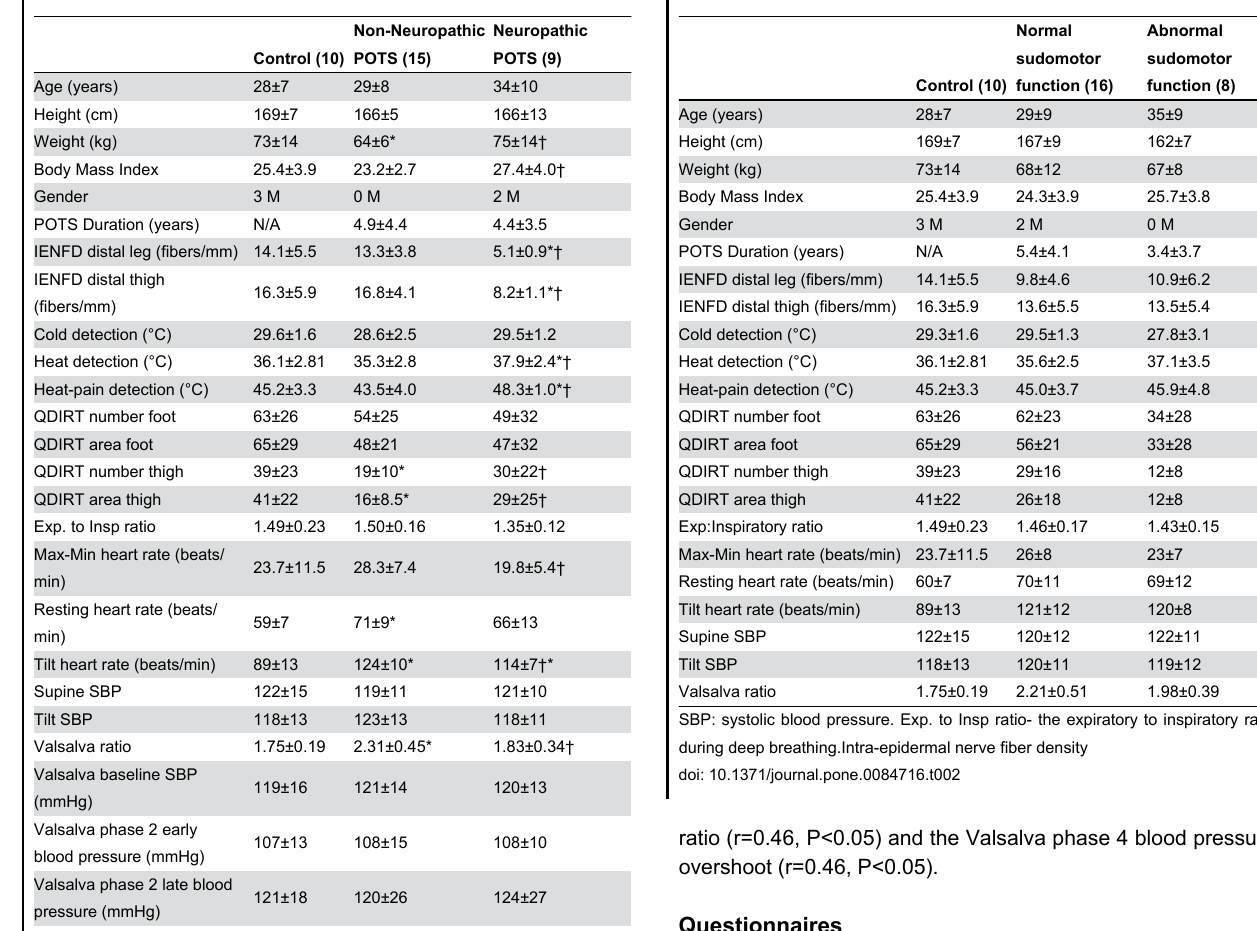
Table 2. Results in individuals with normal and abnormal sudomotor function.